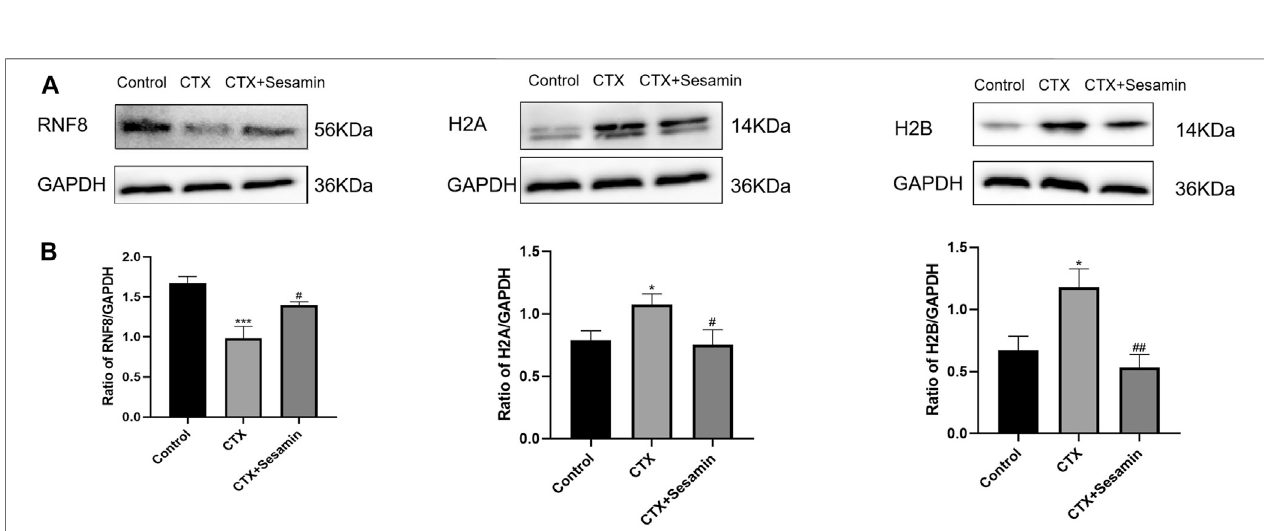
FIGURE8| Effectsofsesamin(200 mg/kg)ontheexpressionofRNF8,H2A,andH2Binthetesticulartissue. (A) TherepresentativewesternblotanalysisofRNF8, H2A,andH2Bactivationinthetesticulartissueforthedifferentgroups. (B) StatisticalanalysisofthegrayvalueofRNF8, H2A,andH2Bforthedifferentgroups.Thedata indicate the mean ± standard error (n (cid:2) 6). *** p < 0.001 vs. the control group; # p < 0.05 vs. the CTX group.